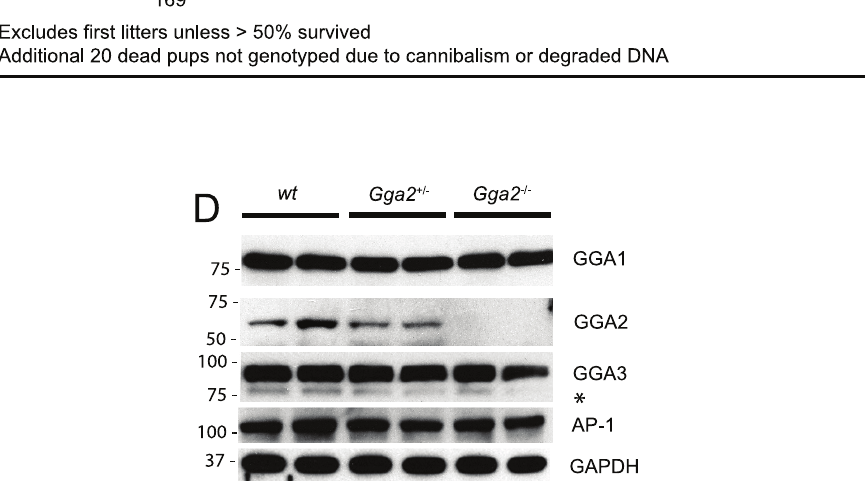
Figure 3. Analysis of Gga2 null mice (TIGM strain). A) The position of the gene-trap within intron-1 of the mouse Gga2 gene (cell line, IST10483E10) is shown. As a consequence of this gene-trap, normal messenger RNA (mRNA) is disrupted by the splice acceptor site of the engrailed-2 leader sequence fusing with codon-33 (encoding L33) of the mouse Gga2 gene. Gga2 primer sets fwd1/rev1 and fwd1a/rev2 (Figure S1A) were used to clearly distinguish between wt and null genotypes, respectively. B) PCR of genomic DNA was performed using Gga2 specific primers (reactions i) or a Gga2 specific primer in combination with a gene trap specific primer (reactions ii). PCR band in reactions (i) indicates wt genotype, while PCR band in reactions (ii) indicates null genotype. C) PCR was performed using genomic DNA from newborn pups of TIGM Gga2 + / 2 crosses. 169 pups were analyzed and homozygous insertion of the gene-trap into the Gga2 gene was determined to be 95% lethal by 3 weeks of age. D) Western blot analysis of TIGM Gga2 mouse brain lysates probed for GGA1, GGA2, GGA3, AP-1 and GAPDH. * denotes a GGA1- cross reacting band (see Figure S4).